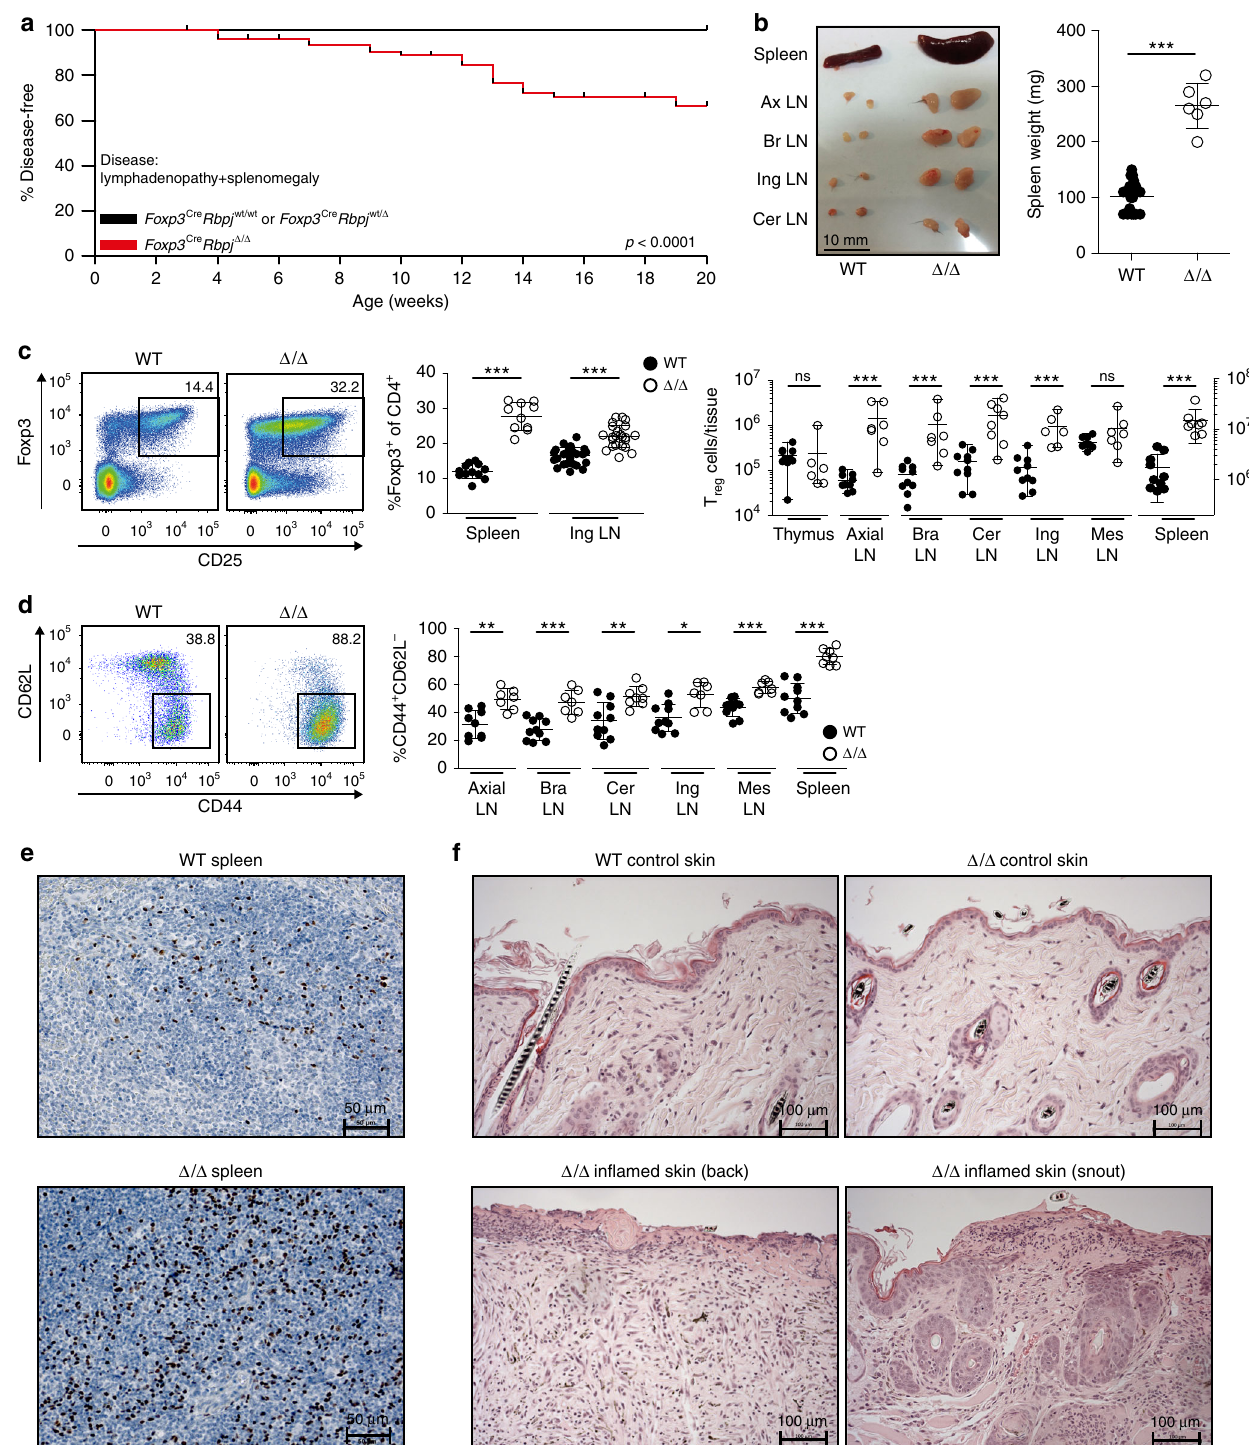
we studied T conv polarization. In spleen and LN, T conv cells became activated and differentiated into effector/memory T cells by down-regulation of CD62L and up-regulation of CD44. Fur- thermore, the absolute number increased by about 5 – 10-fold (Fig. 3a). Treatment of T cells from WT and affected Δ / Δ animals with phorbol-12-myristate-13-acetate (PMA) and Ionomycin to measure intracellular cytokine expression revealed higher fre- quencies of T conv cells from affected Δ / Δ animals producing IL-2, IL-4, and IL-13, while T reg cells remained unchanged (Fig. 3b).